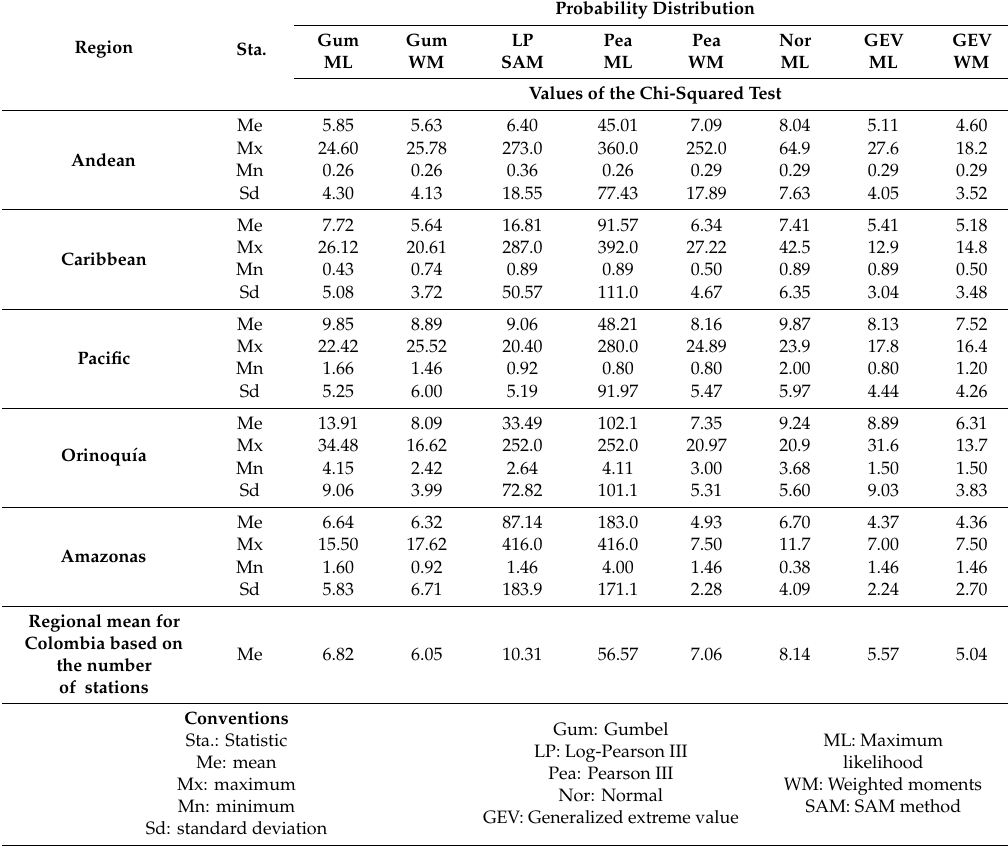
Table 2. Adjustments for the hydrological probability